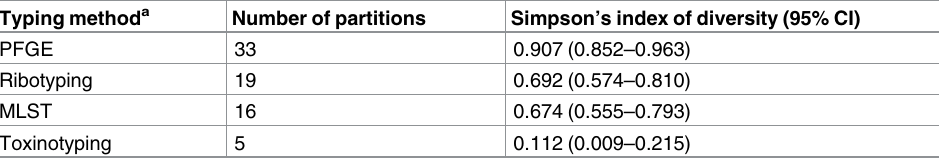
Table 2. Comparison of four different epidemiological typing methods using Simpson’s index of diversity.